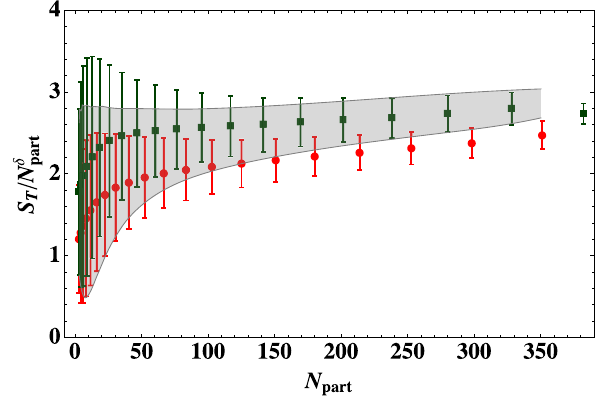
Fig. 5 Glauber model predictions [74] for S T scaled by N δ δ = 2 / 3 for ALICE Pb+Pb 2760 GeV data as upper (green) squares and PHENIX Au+Au 200 GeV data as lower (red) circles. The shaded band corresponds to the PHENIX data scaled by ( 2760 / 200 ) 0 . 06 , including systematic uncertainties of N